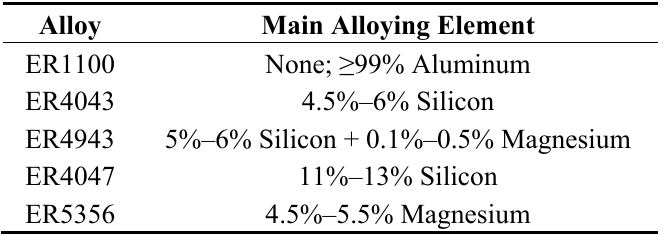
Table 1. Aluminum Weld Alloys and their Major Alloying Elements